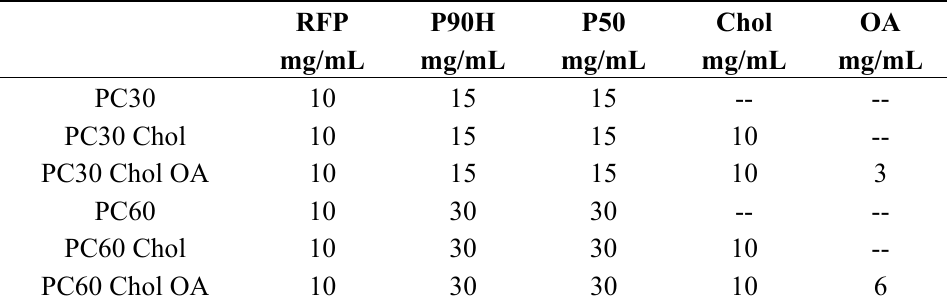
Table 1. Composition of vesicular